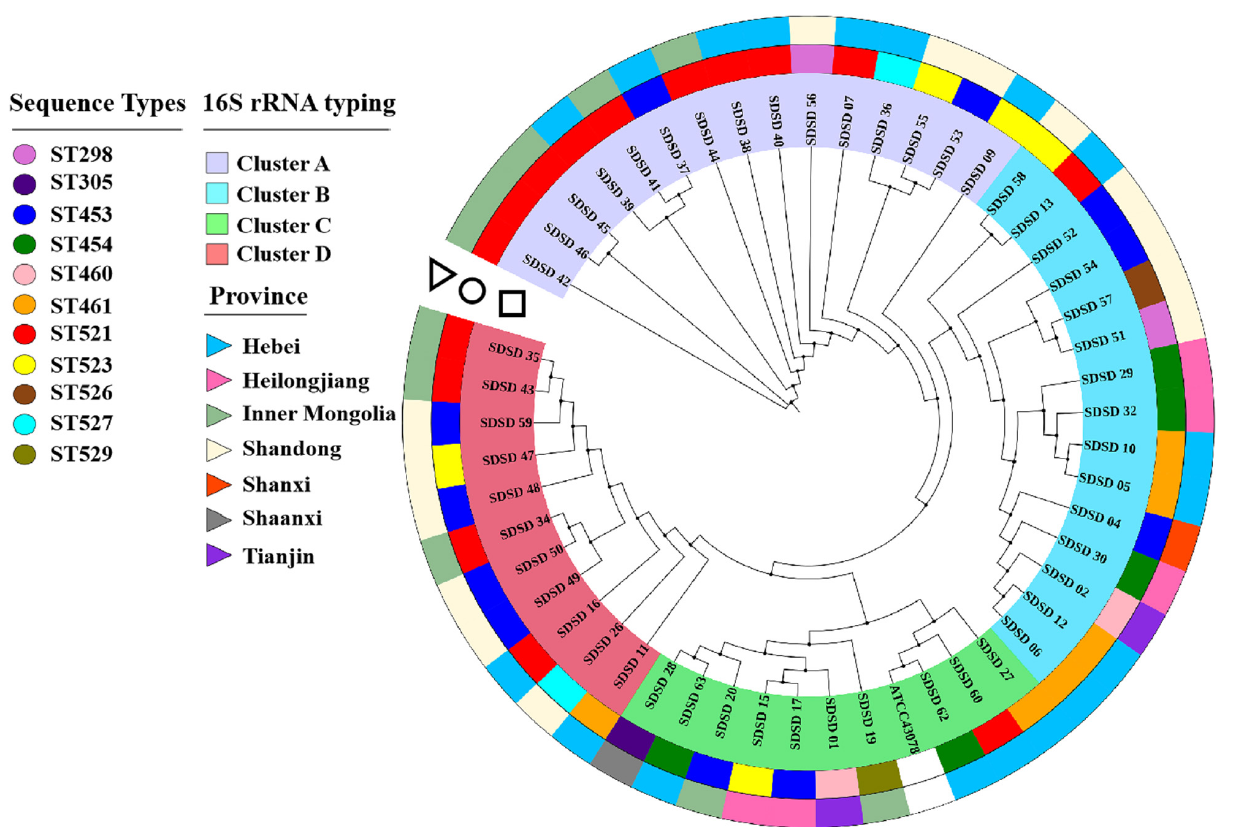
FIGURE 1 | Phylogenetic tree based on 16S rRNA genes (750 bp) of sequence types (STs) and isolation province, with phylogenetic relationships among 51 Streptococcus dysgalactiae subsp. dysgalactiae (SDSD) isolates, and reference strain ATCC 43078. This tree was constructed with MEGA X and was overlaid with information regarding sequence types (STs) and isolation provinces using the iTOL web server (https://itol.embl.de/). The first ring (circle) indicated the distribution of 51 SDSD isolates into 11 distinct STs (ST298, ST305, ST453, ST454, ST460, ST461, ST521, ST523, ST526, ST527 and ST529). The second ring (triangle) indicated that 51 SDSD isolates were recovered from 7 provinces (Hebei, Heilongjiang, Inner Mongolia, Shandong, Shanxi, Shaanxi, and Tianjin).